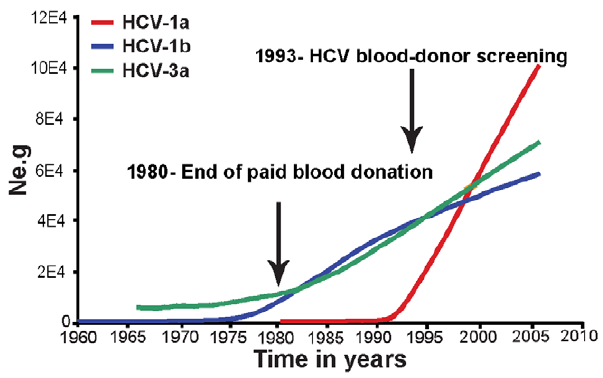
Figure 2. Patterns of population growth for HCV1a, 1b and 3a. The colored lines in the strict clock Bayesian skyline plots show the superimposed median values ( y -axis) of relative genetic diversity ( Ne.g , where Ne is the effective population size and g the inter-host generation time) through time in years for each subtype. Vertical arrows indicate the introduction of control measures in 1980 (end of paid donation) and 1993 (implementation of screening for HCV in blood banks) aimed to hamper HCV spread by blood products in Brazil.